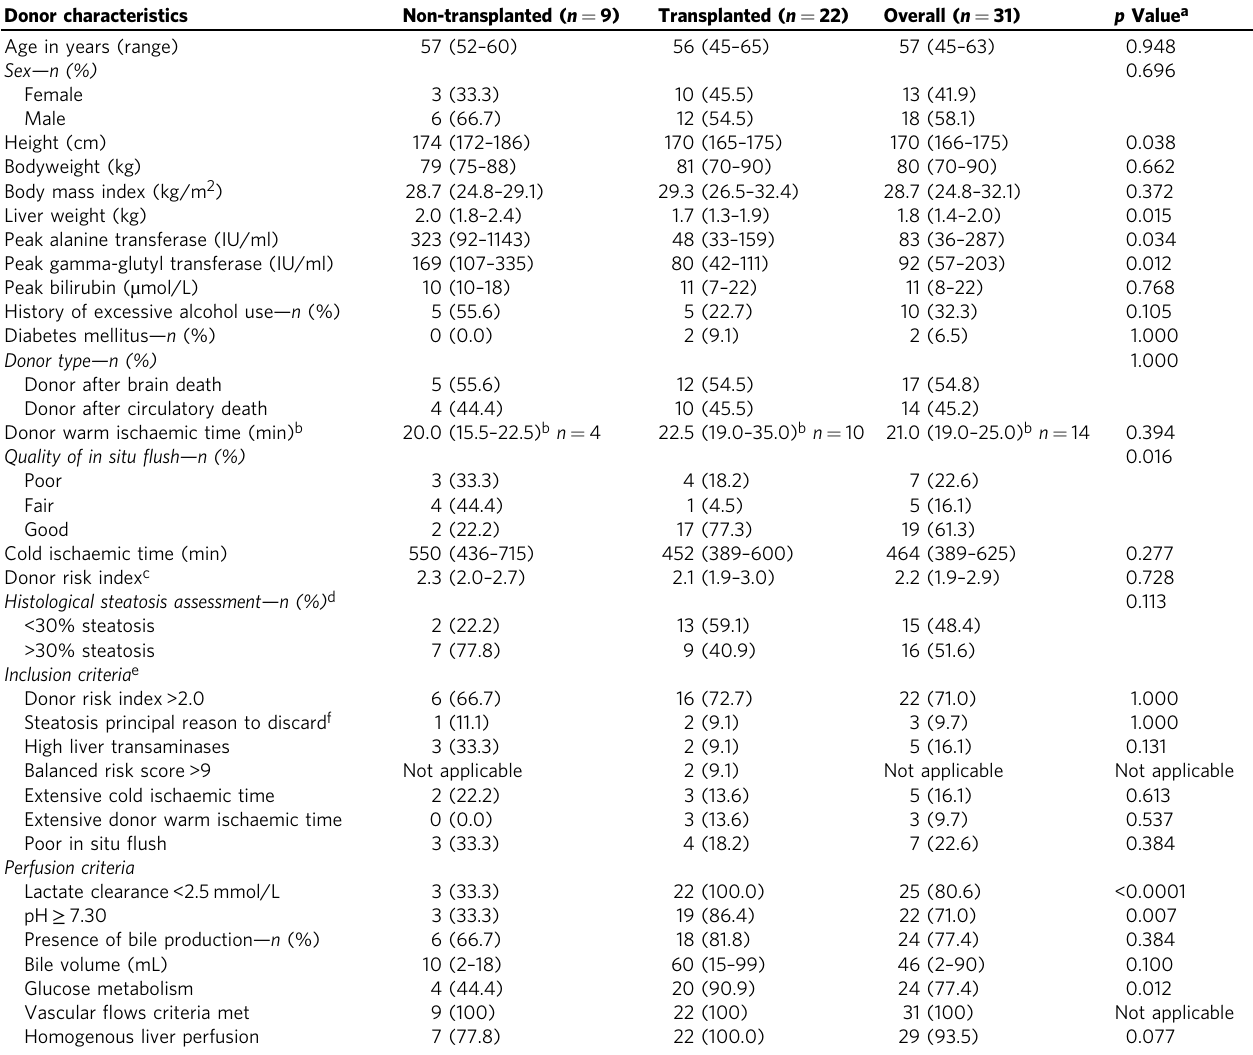
Table 1 Donor and liver characteristics (median, interquartile